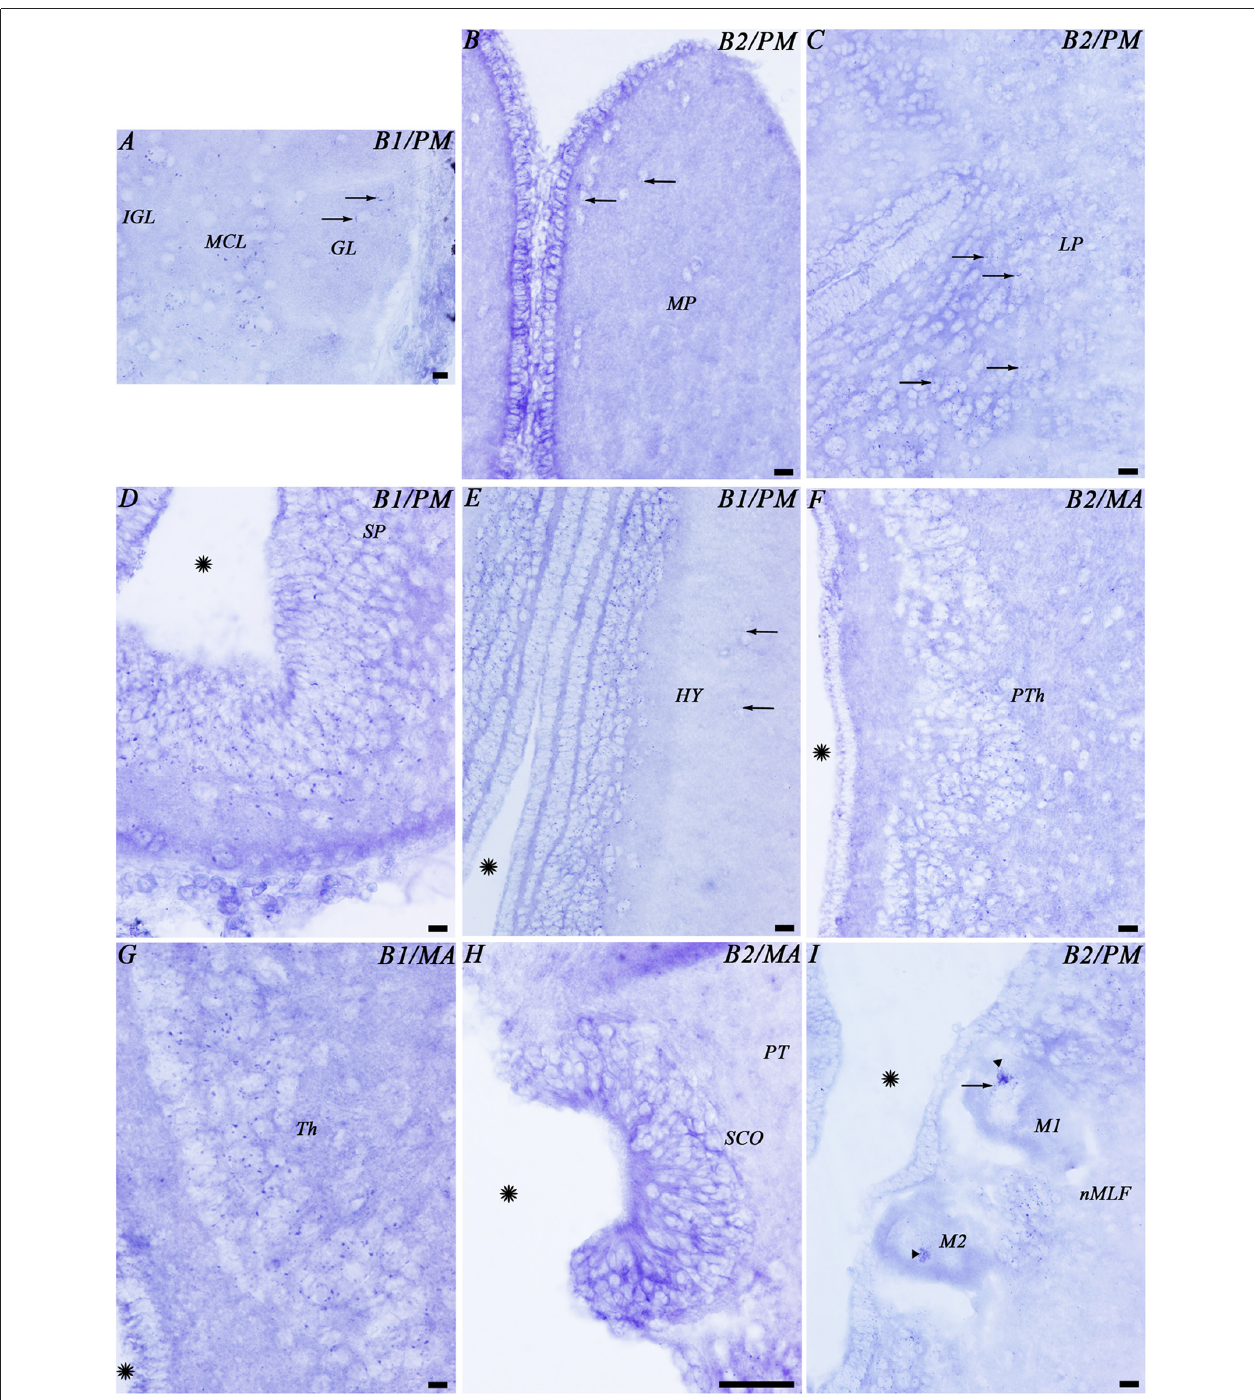
FIGURE 5 | Photomicrographs from different regions of the prosencephalon showing expression of both GABA B transcripts. Abbreviations as in Figure 4 . (A–I) Photomicrographs of the forebrain regions indicated in Figure 4 . (A,D,E,G) GABA B1 . (B,C,F,H,I) GABA B2 . Arrows indicate small positive dots. Arrowheads indicate accumulations of transcript expression in giant cells. Asterisks indicate the ventricle. Scale bars = 50 µ